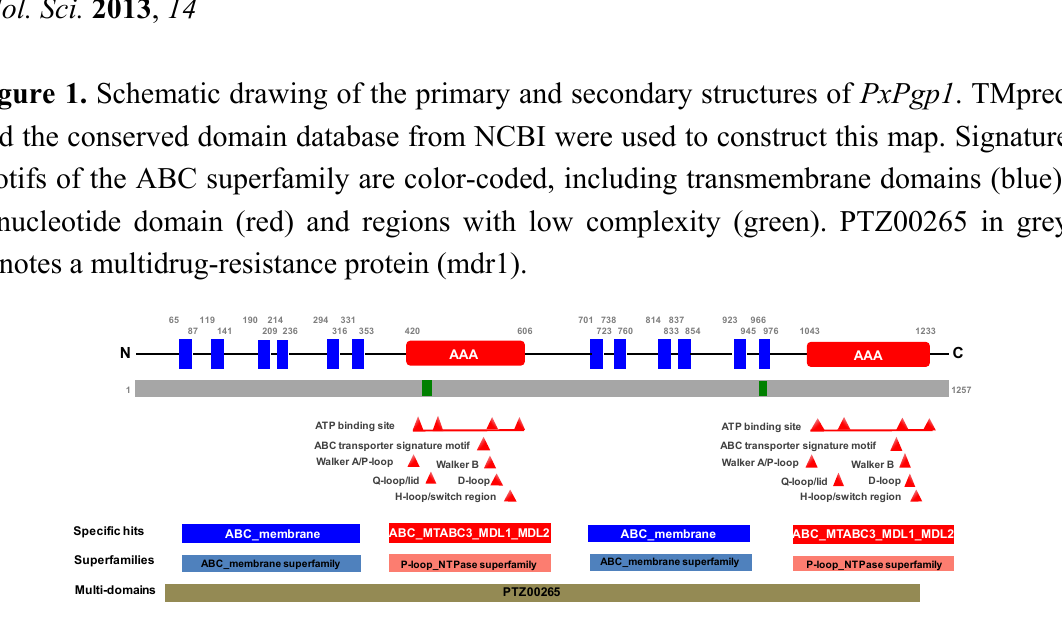
Figure 2. Phylogenetic relationship of PxPgp1 with other insect Pgps. The percentage of replicate trees in which the associated taxa clustered together in the bootstrap test (1000 replicates) is shown next to the branches [52]. Evolutionary analyses were conducted in MEGA5.05